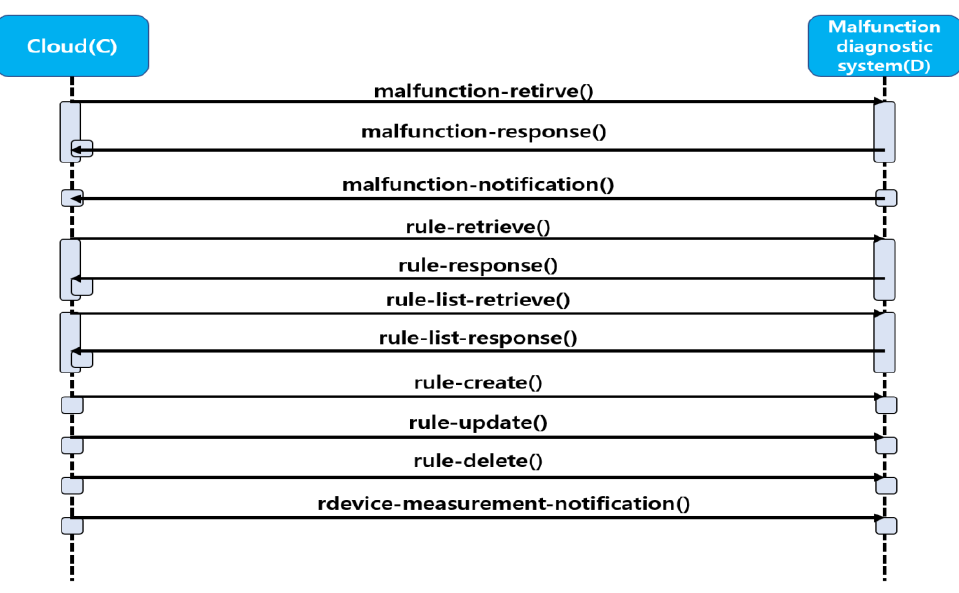
Figure 6. Example of a system interface for users to diagnose device malfunctions through the cloud.